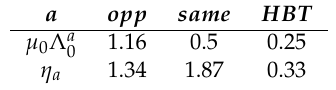
Table 1. The value of the parameters in Formulas (35) and (36) for the charge-wise correlation functions of a string: Λ opp ( ∆ η ) and Λ same ( ∆ η ) , obtained by the fit procedure, presented in Figure 1. a opp same HBT µ 0 Λ a